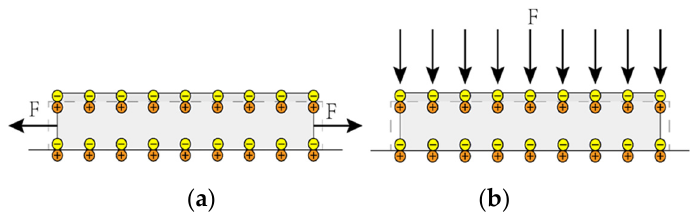
Figure 1. Two working modes. ( a ) d 31 mode; ( b ) d 33 mode.